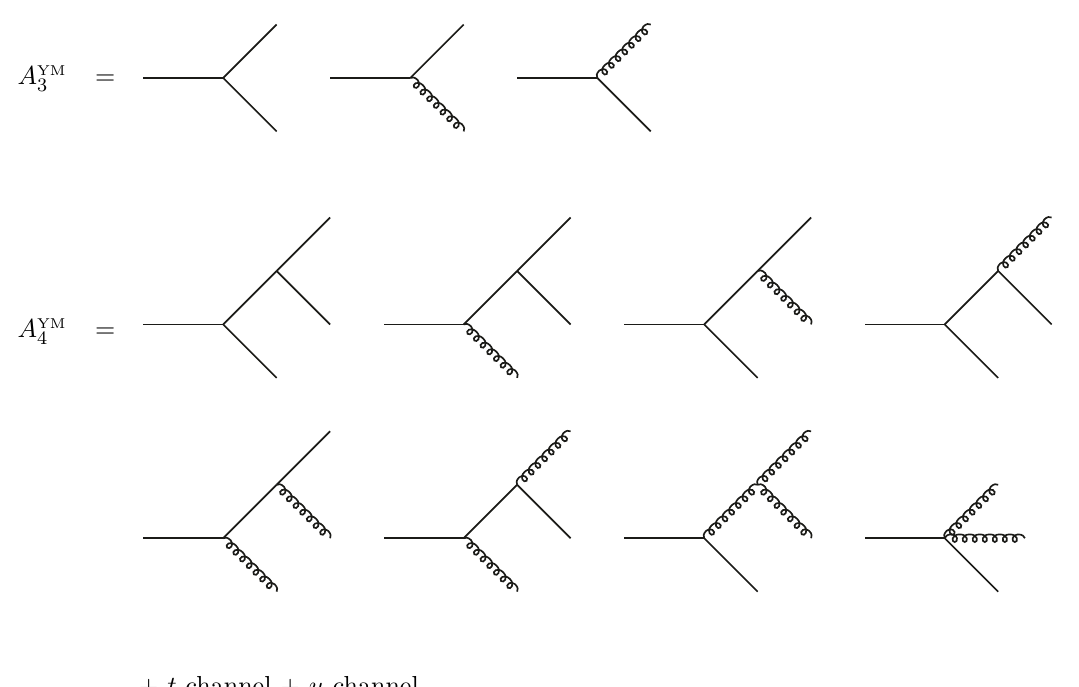
Figure 2 . The three- and four-point scattering amplitudes of YM theory derived from the one- point correlator of the field strength in eq. (4.8) using the Feynman rules derived from the equation of motion in eq. (4.3). The solid and curly lines depict field strengths and gauge fields, respectively. Embedded within in each diagram is a subdiagram of solid lines describing a field strength that branches purely through F 3 interactions. Like minimally coupled scalars, these field strengths repeatedly emit gauge fields that in turn cascade down into other gauge fields via the nonlinear interactions of YM theory. Since the gauge fields never branch back into field strengths, they are effectively background fields and induce no back-reaction. Note that the root leg is always a field strength, while the leaf legs can be either gauge fields or field strengths, since these are generated at asymptotic infinity by the source and its derivative,